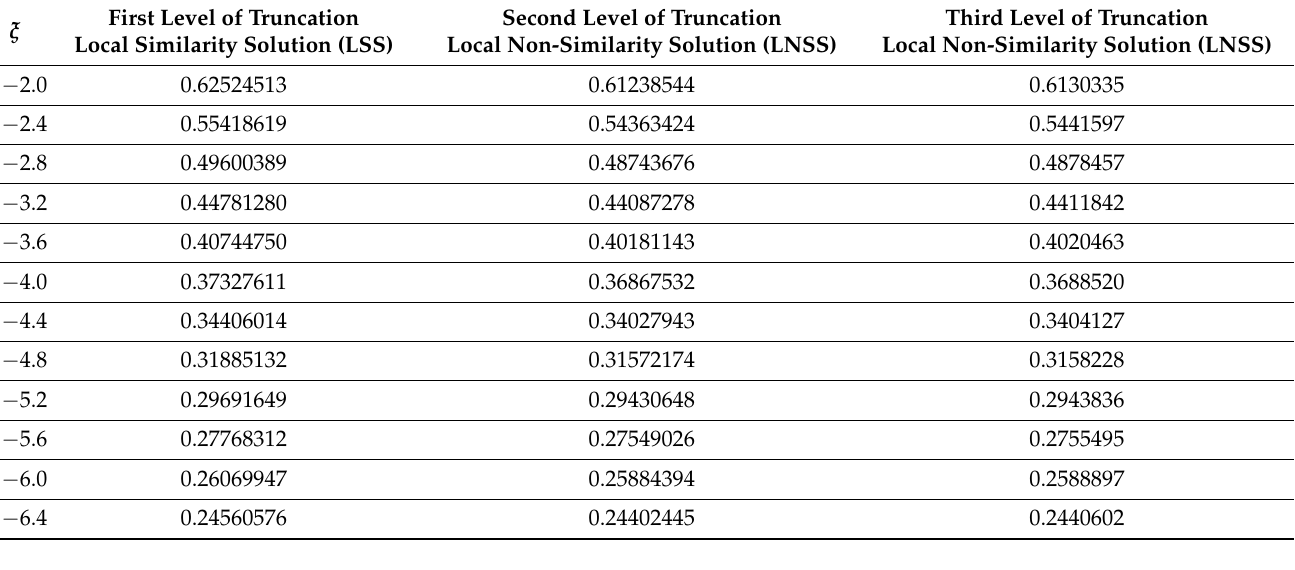
−√ (cid:18) (cid:19) √ p + 1 √ d 2 f ( χ = 0, ξ ) − Cf x Re x = for different values of velocity d χ 2 2